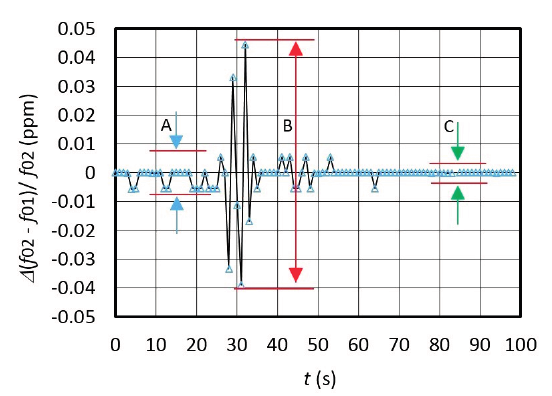
Figure 9. Output frequency dynamic error Δ f out (ppm) during the change of temperature from 25 °C to 37 °C and back to 25 °C (Figures 7 and